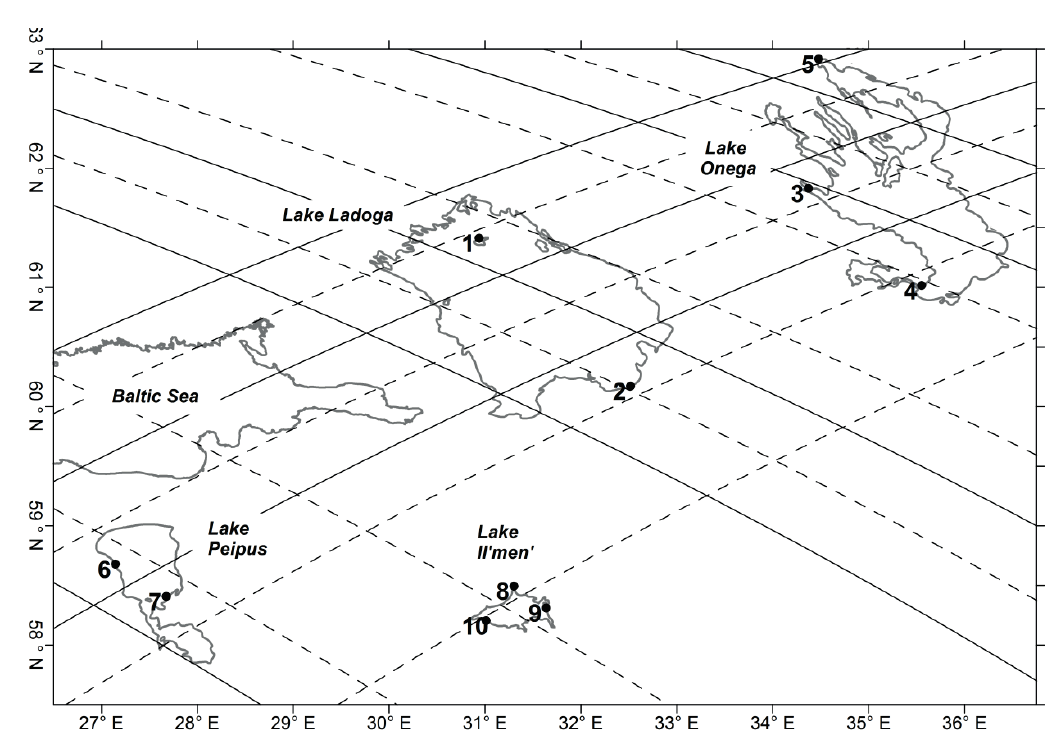
Fig. 1 Position of the T/P and J1/2 satellites groundtracks before (solid line) and after (dashed line) the manoeuver in the water area Lake Ladoga, Lake Onega, Lake Peipus and Lake Il’men’. Black cycles show water level gauges: (1) Balaam and (2) Siaskie Ryadki (Lake Ladoga); (3) Petrozavodsk, (4) Voznesenie and (5) Medvezhyegorsk (Lake Onega); (6) Mustvee and (7) Raskopel (Lake Peipus); (8) Volkhov-Novgorod, (9) Voytsy and (10) Korostyn (Lake